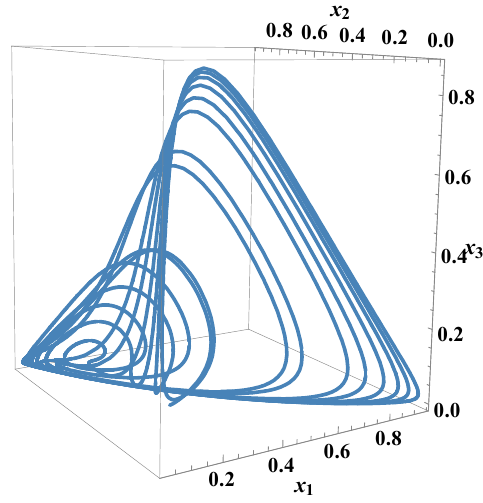
Figure 10. Parametric 3D plot of uncontrolled state vectors. Mathematics 2016 , 4 , 33